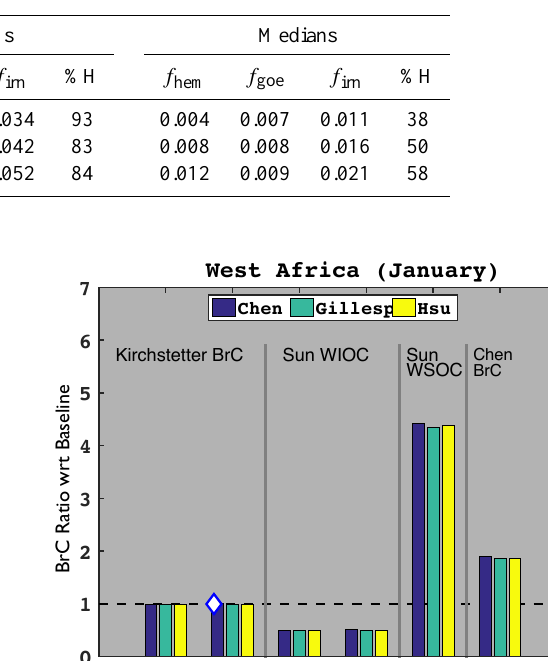
Table 5. Volume fractions of hematite, goethite, and free iron for “pure” dust, and the volume percentage of iron associated with hematite (% H = V hem /(V hem + V goe ) × 100 ) at the West African sites, using different refractive indices for hematite.